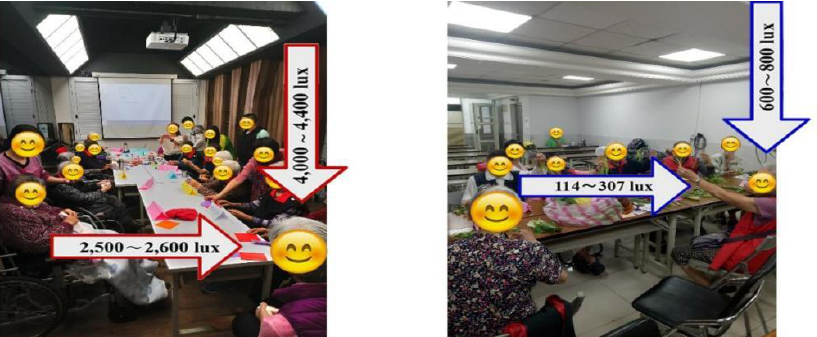
Figure 2. Representative images of the following exposure conditions: bright morning light (2500 lx) or general light (200 lx).